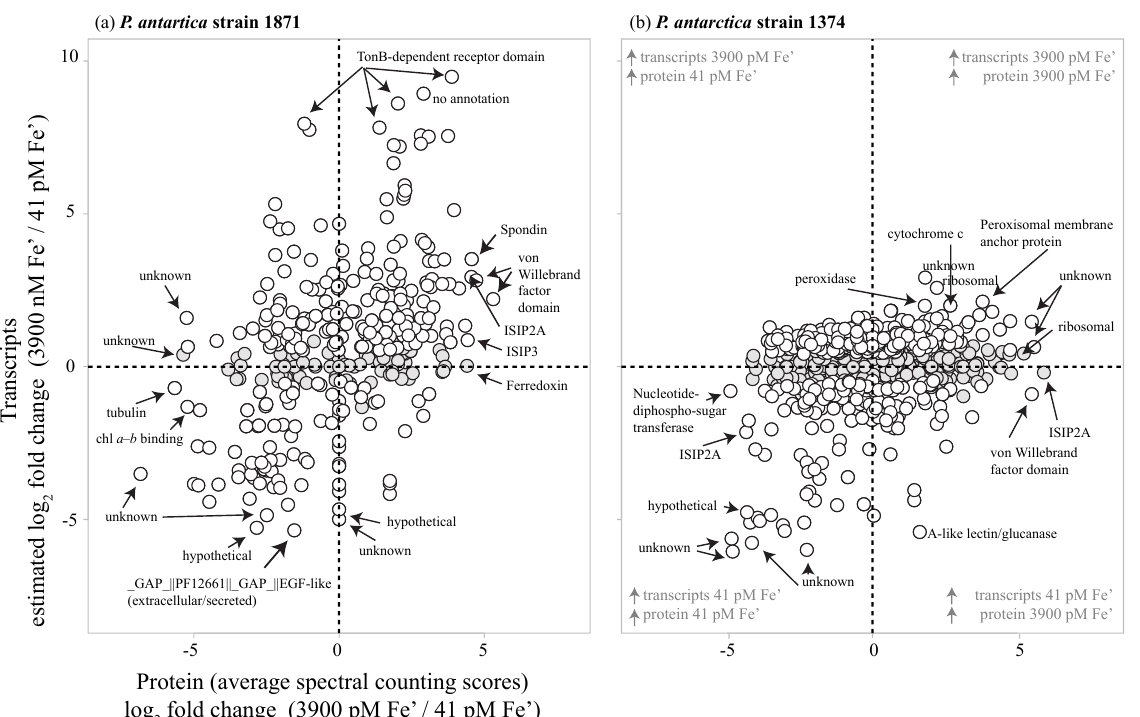
Figure 7. Scatterplots of relative transcript abundance ( y axis) and relative protein abundance ( x axis) for P. antarctica strain 1871 (a) and strain 1374 (b) for a high iron treatment (3900pM Fe’) relative to a low iron treatment (41pM Fe’). Gray circles represent instances in which transcript abundance was not significantly different between conditions ( P ≥ 0 . 99). Quadrants in which relative protein and transcript abundances agree (upper right, lower left) and disagree (upper left, lower right) are noted, as are select genes exhibiting the greatest relative protein abundance and/or transcript abundance under a given